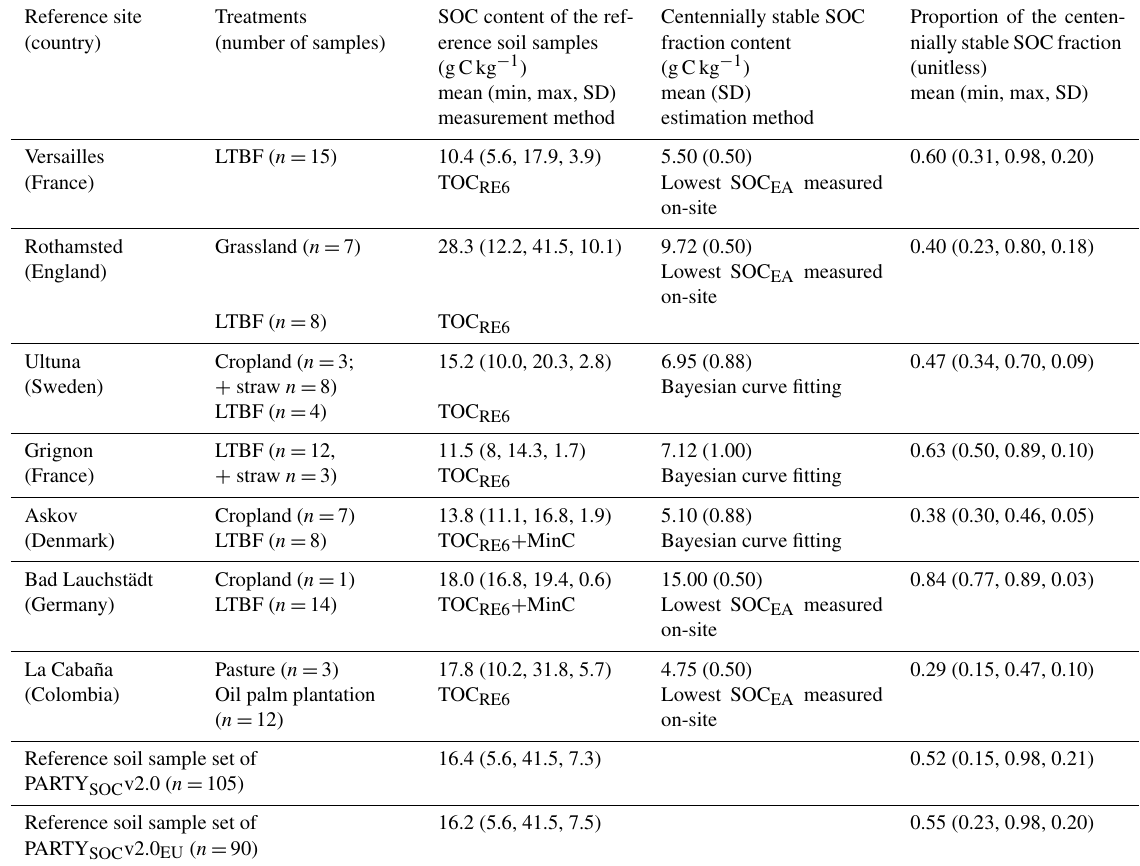
Table 1. Main statistics for soil organic carbon contents, site-specific contents of the centennially stable SOC fraction, and resulting pro- portions of centennially stable SOC fraction in topsoils of the seven reference sites used as the training sets for PARTY SOC v2.0 and Table S3. Abbreviations are as follows. SOC: soil organic carbon; LTBF: long-term bare fallow; min: minimum; max: maximum; SD: standard